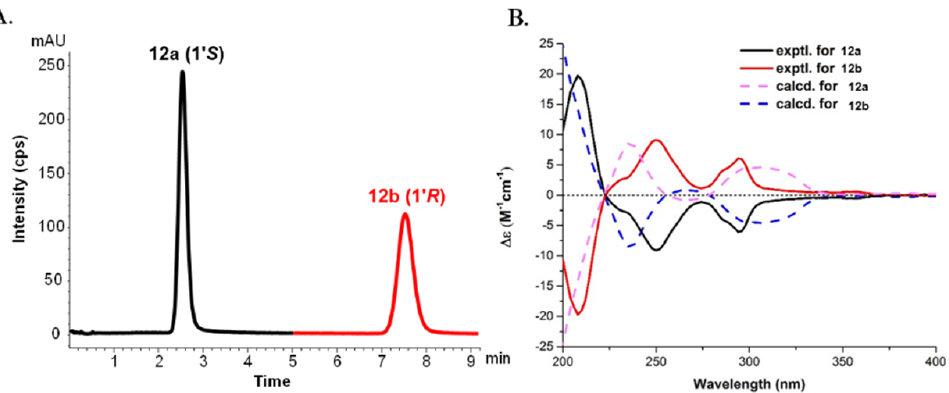
Figure 5. The chiral HPLC separation ( A ) and experimental and calculated ECD data ( B ) of com- pounds 12a and 12b.